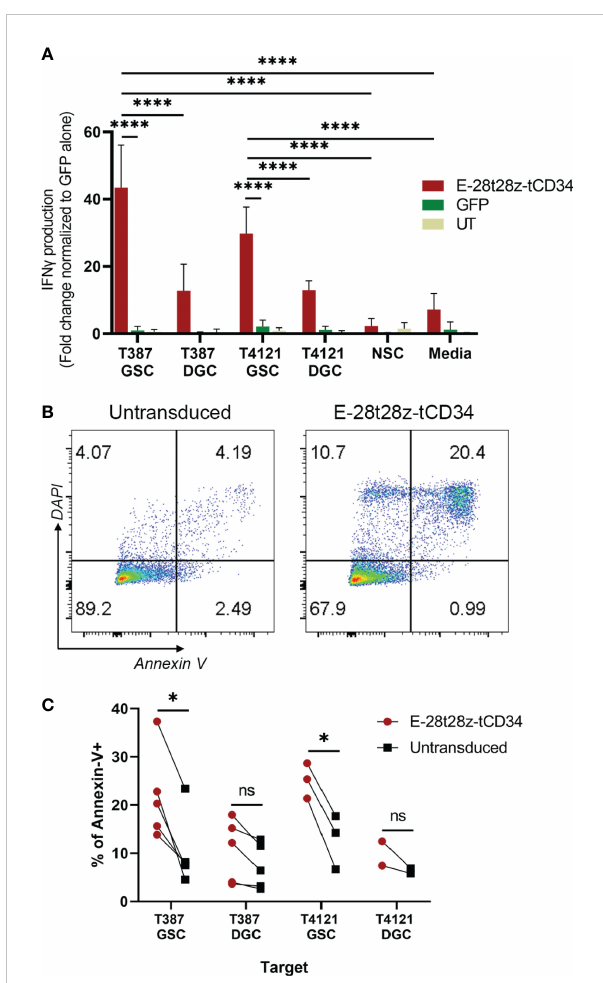
FIGURE 5 In vitro ef fi cacy of the EV CAR-T cells. (A) IFN-gamma secretion results from the E-28t28z-tCD34 CAR-transduced, GFP-transduced and untransduced (UT) T cells after overnight co-culture with different cells, **** = p < 0.0001. (B) Representative dot plot of Annexin-V staining of GSCs after 4-6 hour co-culture with untransduced and E-28t28z-tCD34 cells. (C) Summary of percentage of Annexin-V+ cells following co-culture with the indicated effectors. Target cells include GSC and DGC from two independent donors: T387 and T4121. *p < 0.05 (T387 GSC, and T4121 GSC). n.s.= non statistically signi fi